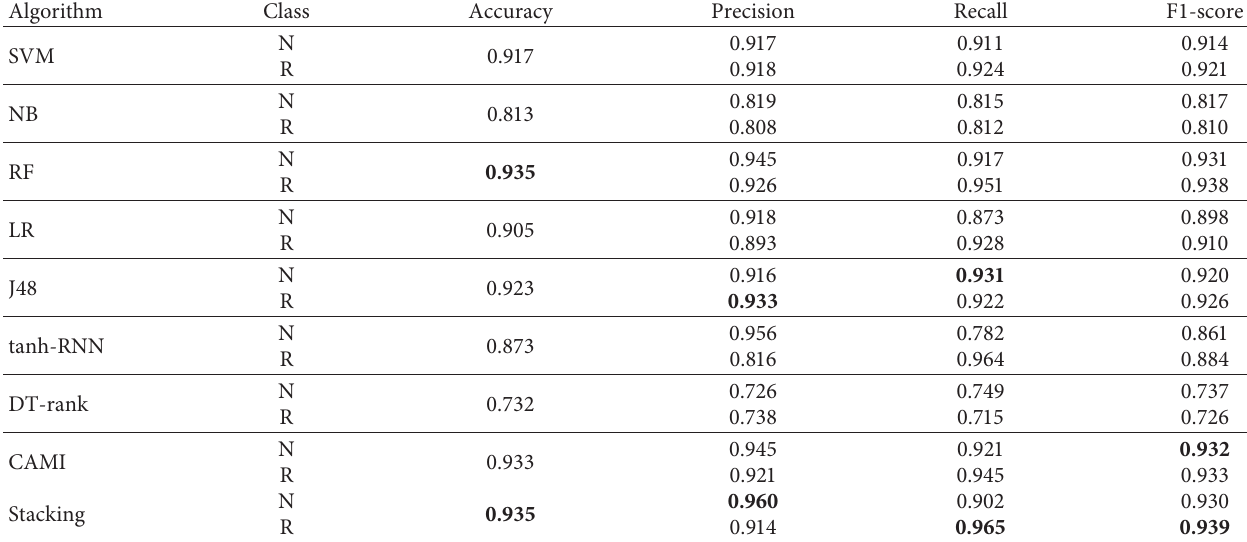
Table 5: Algorithm comparison results.